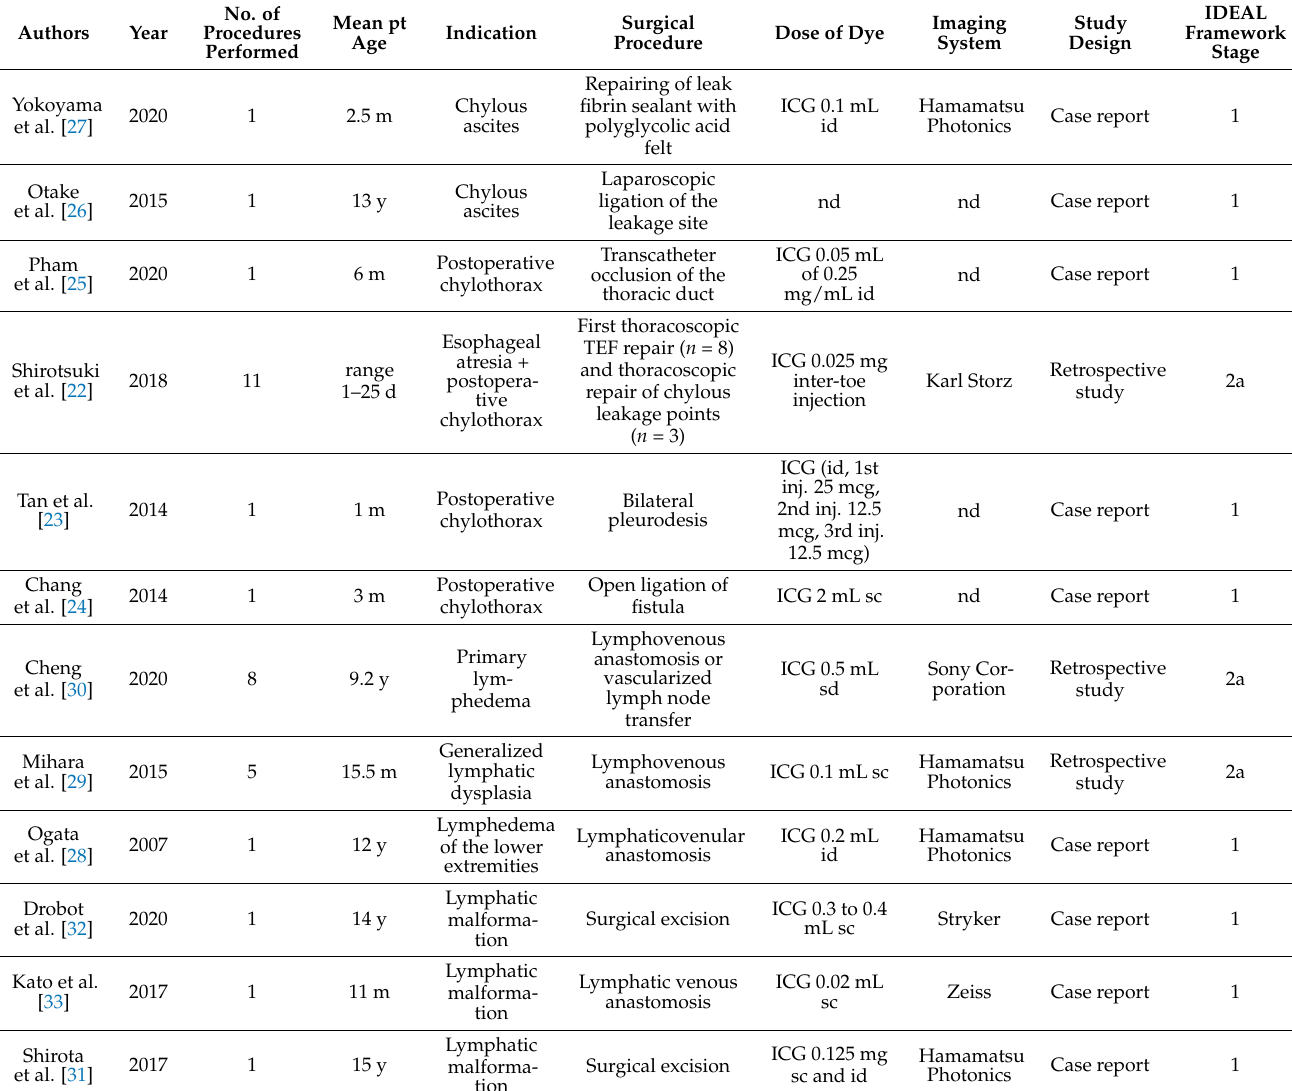
Table 3. Summary for lymphatic flow